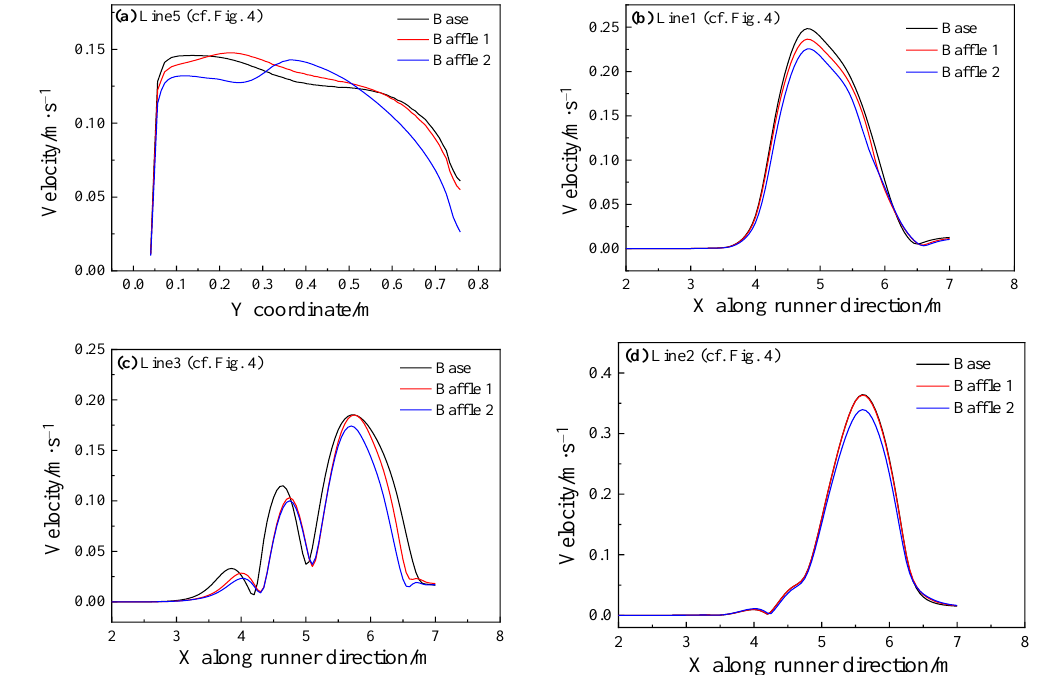
Figure 16. Velocity distribution of different main troughs near the wall without or with baffles. The flow at the two cross-sections 5.5 m upstream and 6.6 m downstream are selected for analysis, and the results are shown in Figure 17. The volume flow of the Baffle 1 and Baffle 2 models has decreased compared with the base model: the volume flow of Baffle 1 has dropped by 5.0% and for Baffle 2 by 6.4%. In Figure 17b, the addition of baffles effectively increases the downstream flow rate. It is due to the reduction in the return metal flow rate and direct downstream of much more hot metal, resulting in an increase in the downstream surface flow rate by 11%.